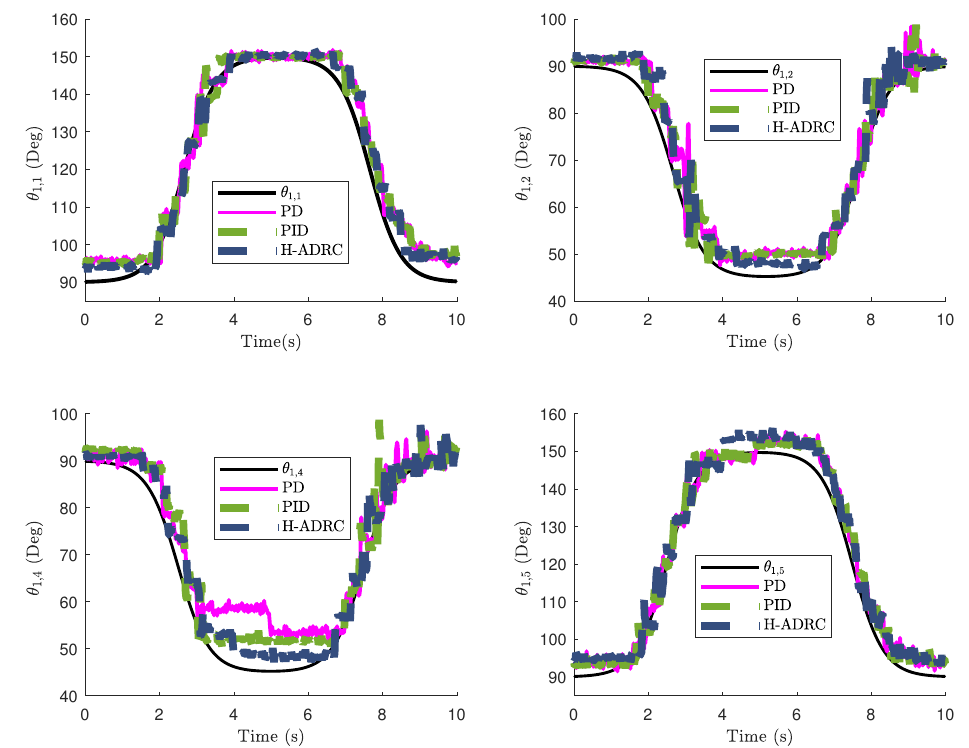
Figure 11. Comparison of the trajectory tracking task in the WBRD by means of different control techniques.